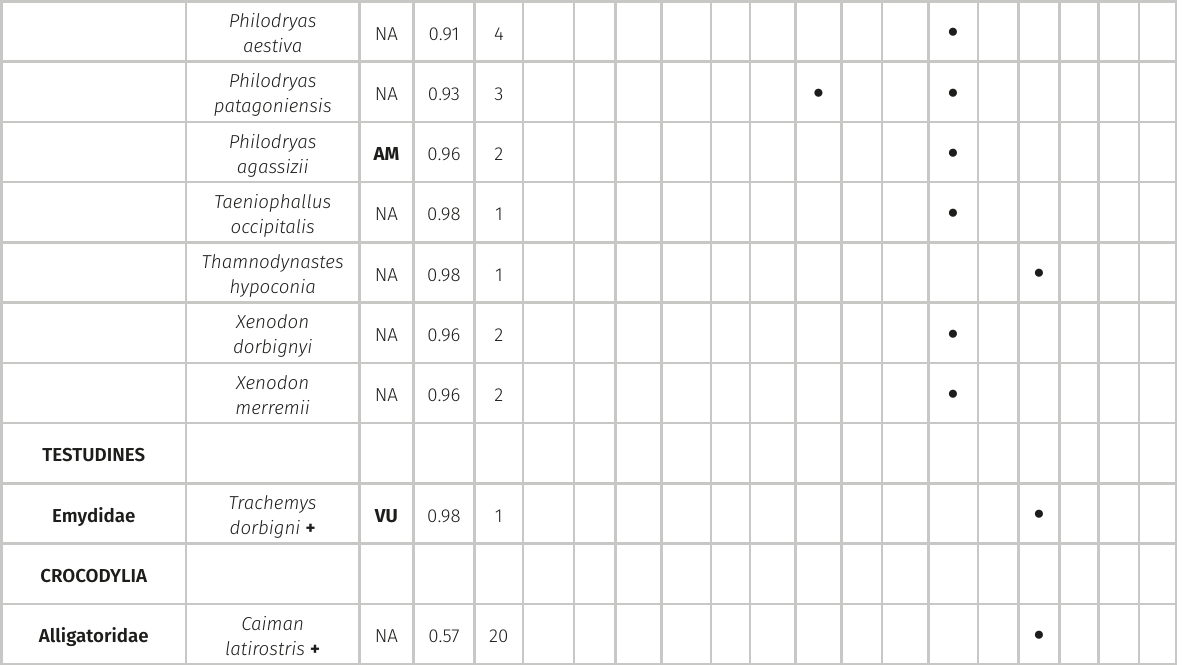
(Table IV). The rocky outcrops of PTC harbored the following exclusive species: Ameivula sp.,